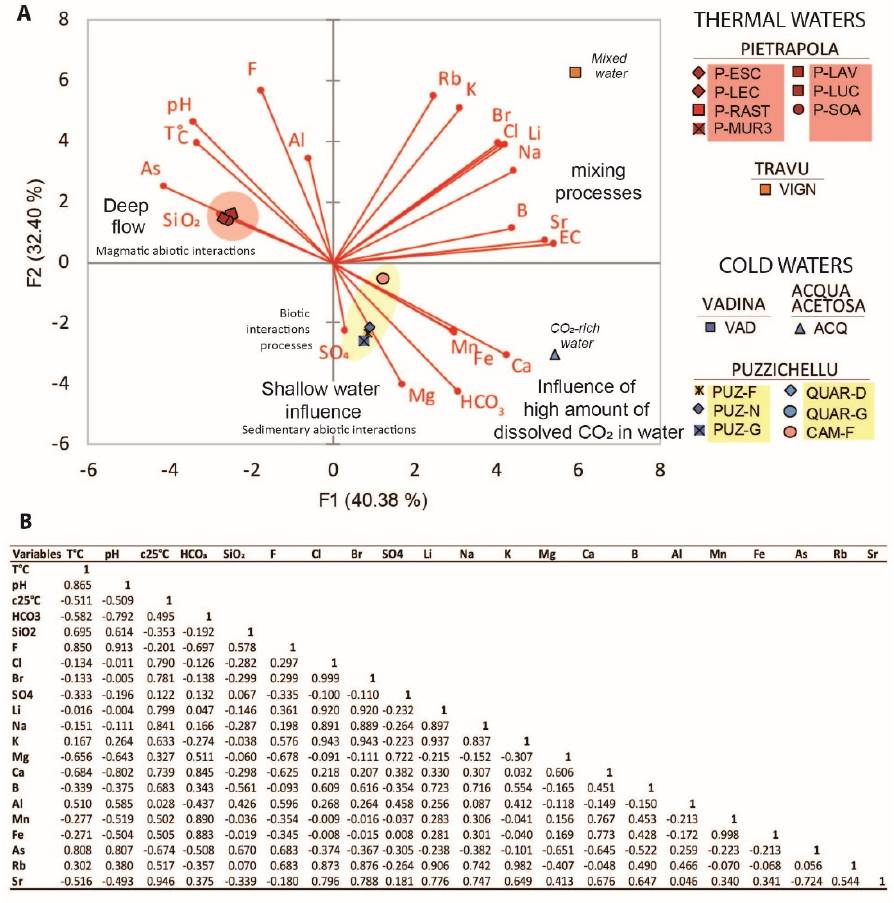
Figure 6. Principal Component Analysis (PCA) discriminating the origin of trace elements and the geological influence on spring water composition. The spring group of Pietrapola is displayed in red background while Puzzichellu is displayed in yellow background. ( A ) This figure displays both correlation factors (F1 and F2) according to variables (parameters) and observations (springs contents); ( B ) table displaying the correlation matrix associated to ( A ), according to Pearson (n − 1).